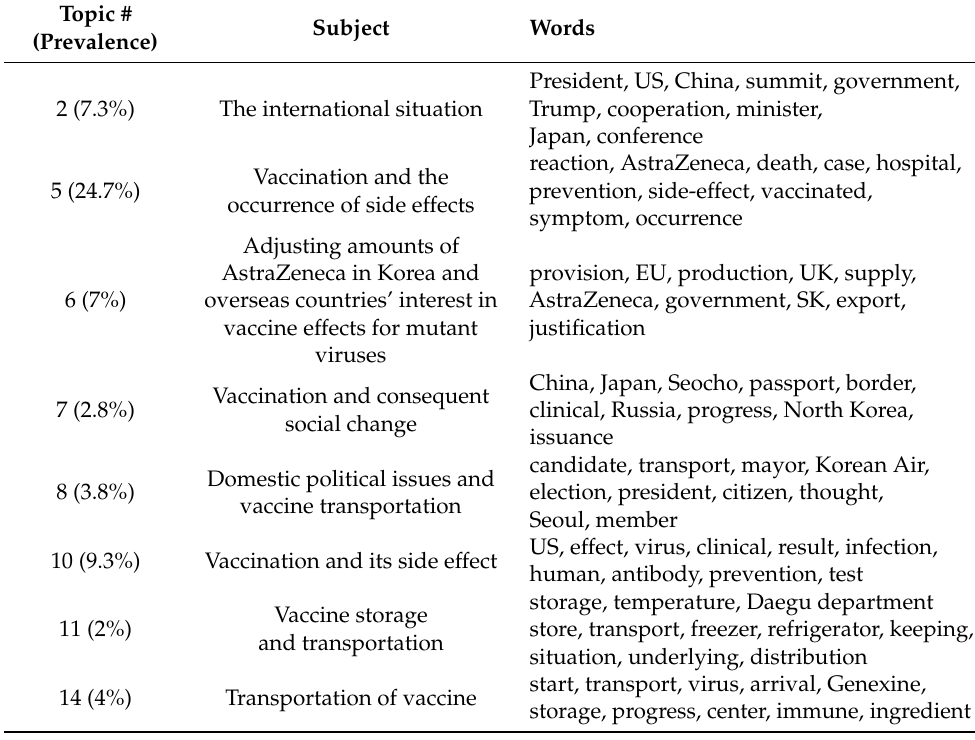
Table 4. Topics drawn from Phase 3 (26 February 2021–31 March